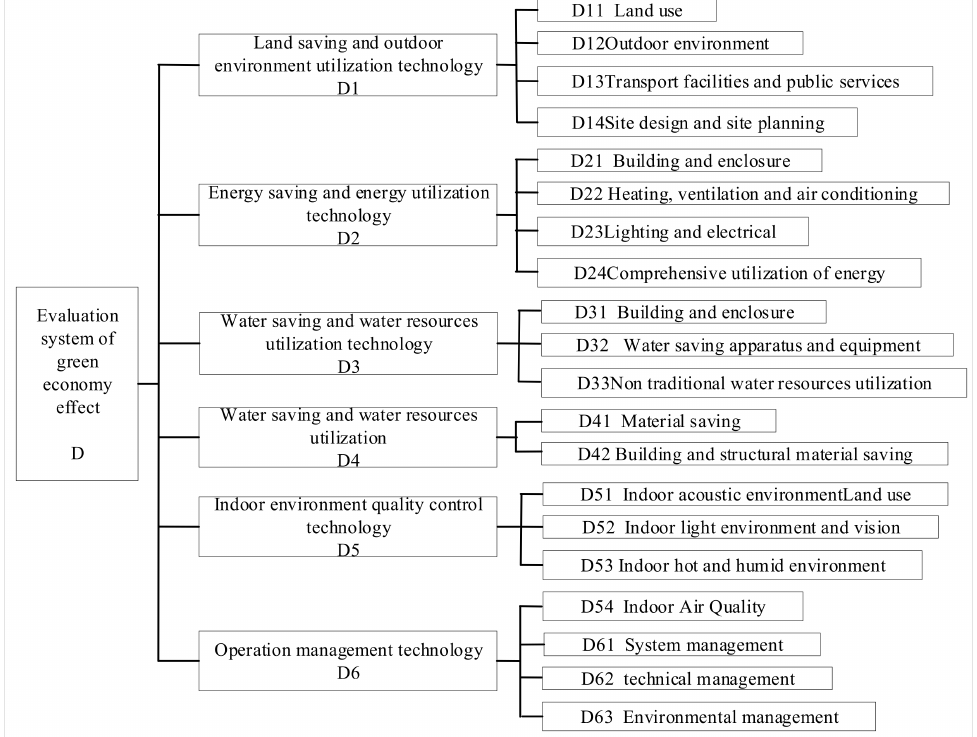
Figure 1. Schematic diagram of hierarchical transmission